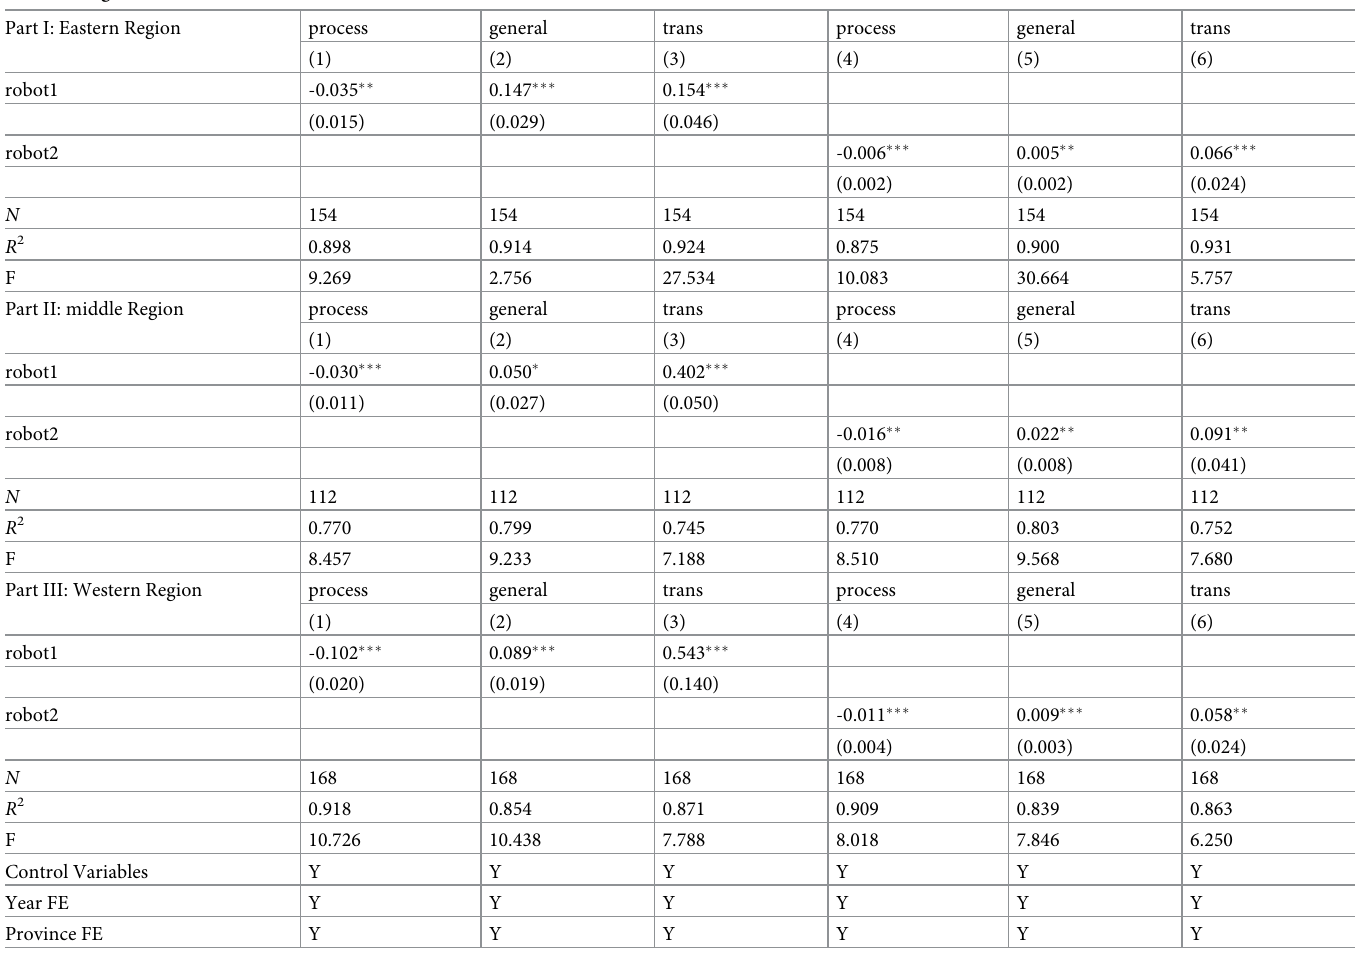
Table 6. Regression results for eastern, middle and western